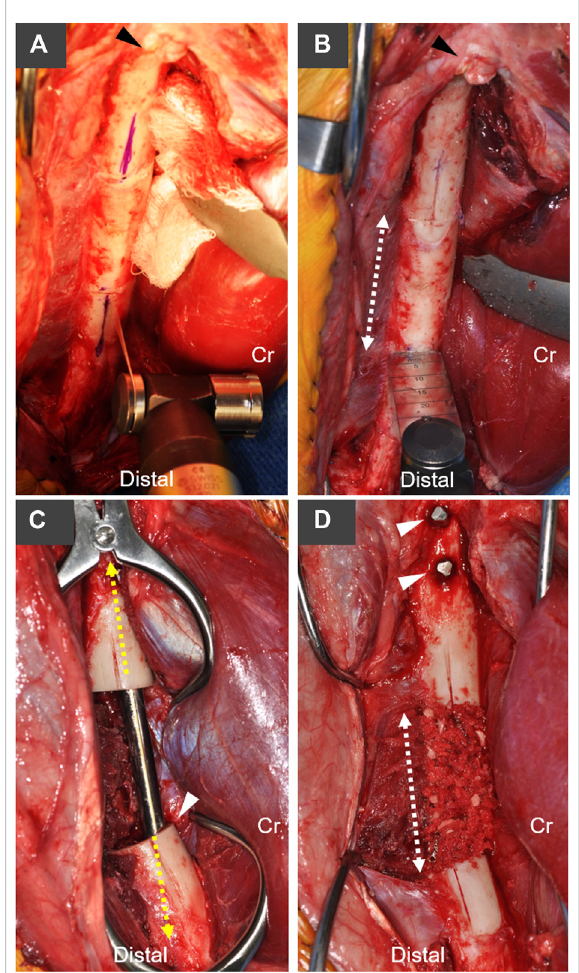
FIGURE 1 Overview of canine critical-sized femoral defect model with stabilization using an AS-ILN. (A) A craniolateral approach to the femur and sti fl e (knee) joint were performed. Longitudinal index marks were created on the lateral surface of the femur with an oscillating saw and sterile marker to maintain rotational orientation of the proximal and distal bone segments. Arrowhead denotes the base of the greater trochanter, Cr denotes cranial (anterior) position. (B) A 4 cm mid-diaphyseal transverse ostectomy was planned (dashed arrow). (C) An 8 mm × 172 mm AS-ILN was placed to stabilize the femur (see Figure 2 for speci fi cs of AS-ILN). Dashed line denotes long axis of AS-ILN. Arrowhead denotes the intentional positioning of the cranial (anterior) cortex adjacent to the AS-ILN in order to position the nail more distally in the femoral condyle. Dogs assigned to the negative control group received no additional treatment at the ostectomy. (D) Dogs assigned to the autograft treatment group received a 10 cm 3 cancellous autograft which was supplemented with morselized cortical bone from the ostectomy. Dashed line denotes the extent of the ostectomy and bone graft. Arrowheads denote